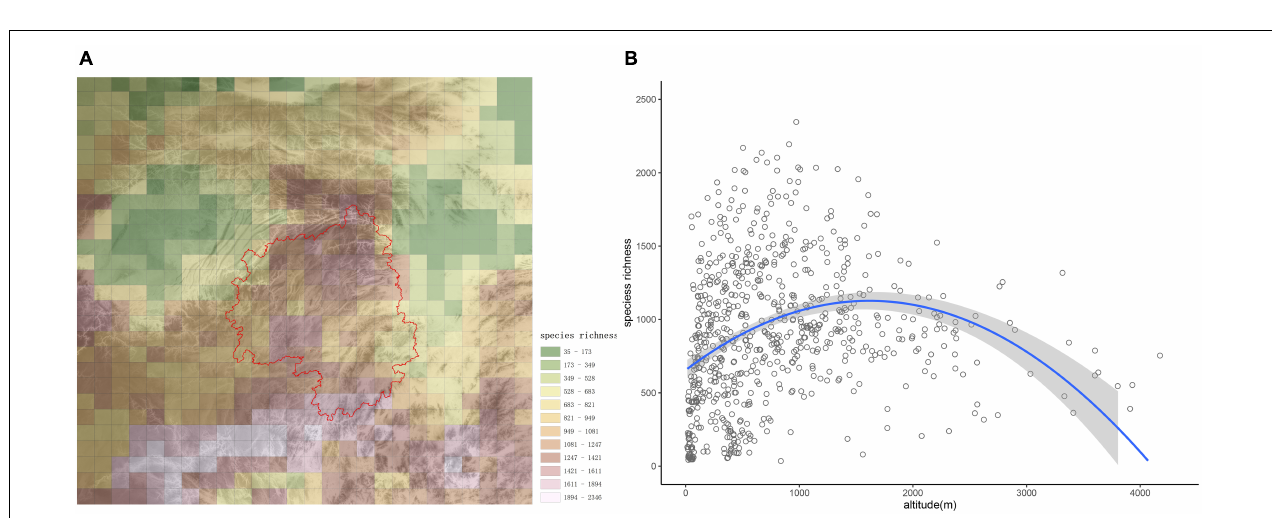
FIGURE 1 | The location of the study region with a raster grid overlaid. The red line delineates the Wuling Mountains.